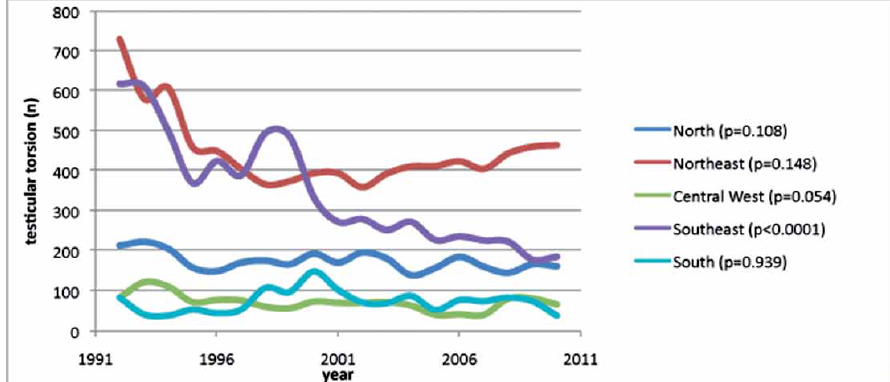
Figure 2 - Historic series of testicular torsion in the public health system in Brazil, 1992-2010 (geographic